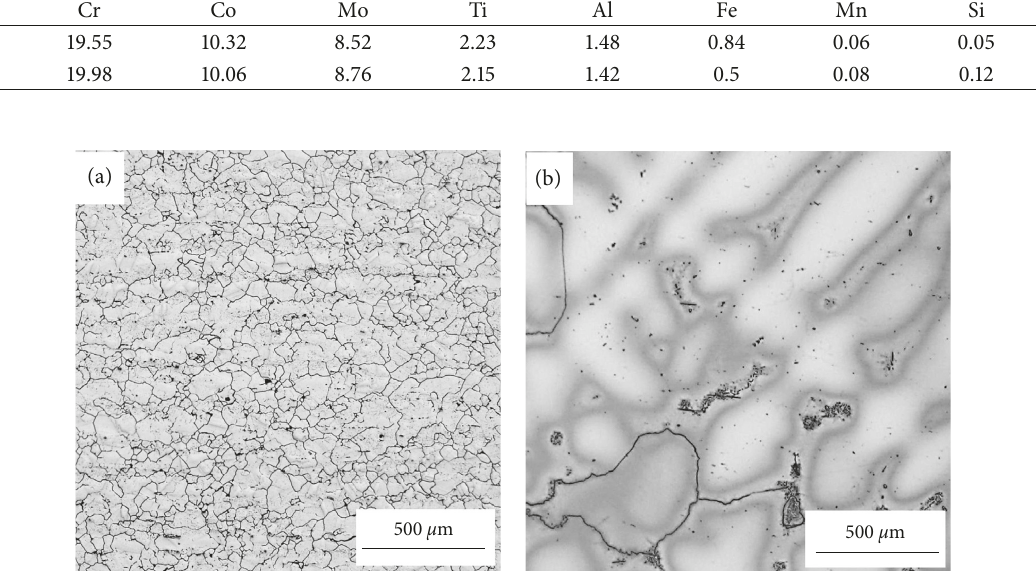
Figure 1: Optical microstructures of Haynes 282 (a) wrought and (b) cast alloys.